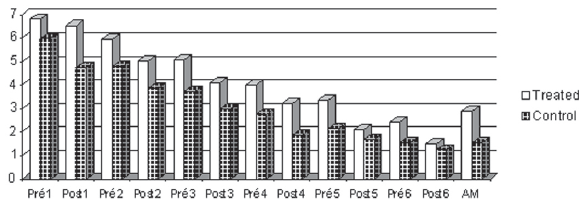
FIGURE 2- Mean pain for treated and control groups with thermal-evaporative